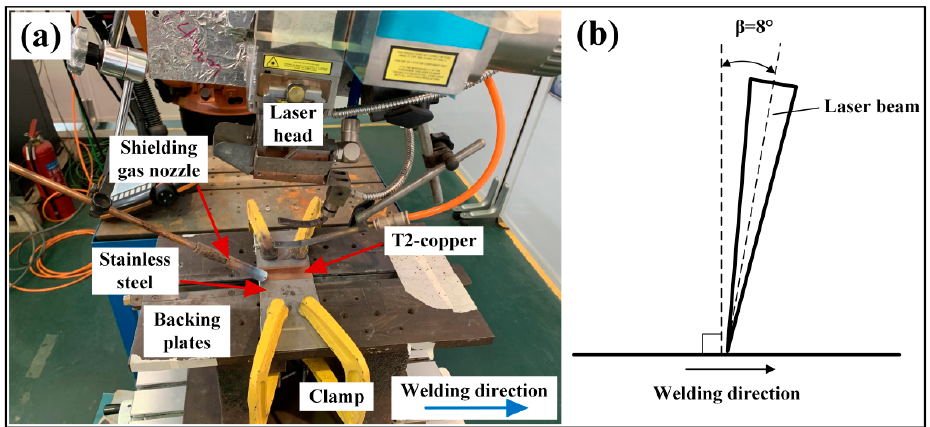
Figure 1. The experimental setup and schematic diagram of laser welding of copper to stainless steel: ( a ) the experimental setup; ( b ) the schematic diagram of the welding process.